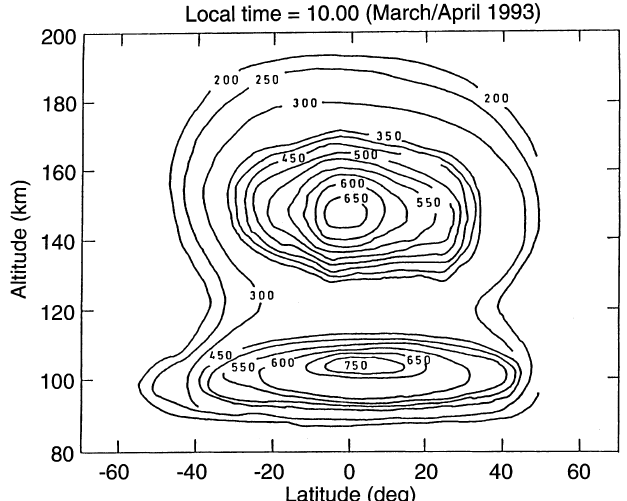
Fig. 7. The latitudinal variation of two monthly (March/April 1993) averaged volume emission rates as measured by wind imaging interferometer (WINDII) at 10 h local time (courtesy of Prof. G. G. Shepherd, York University, Canada)